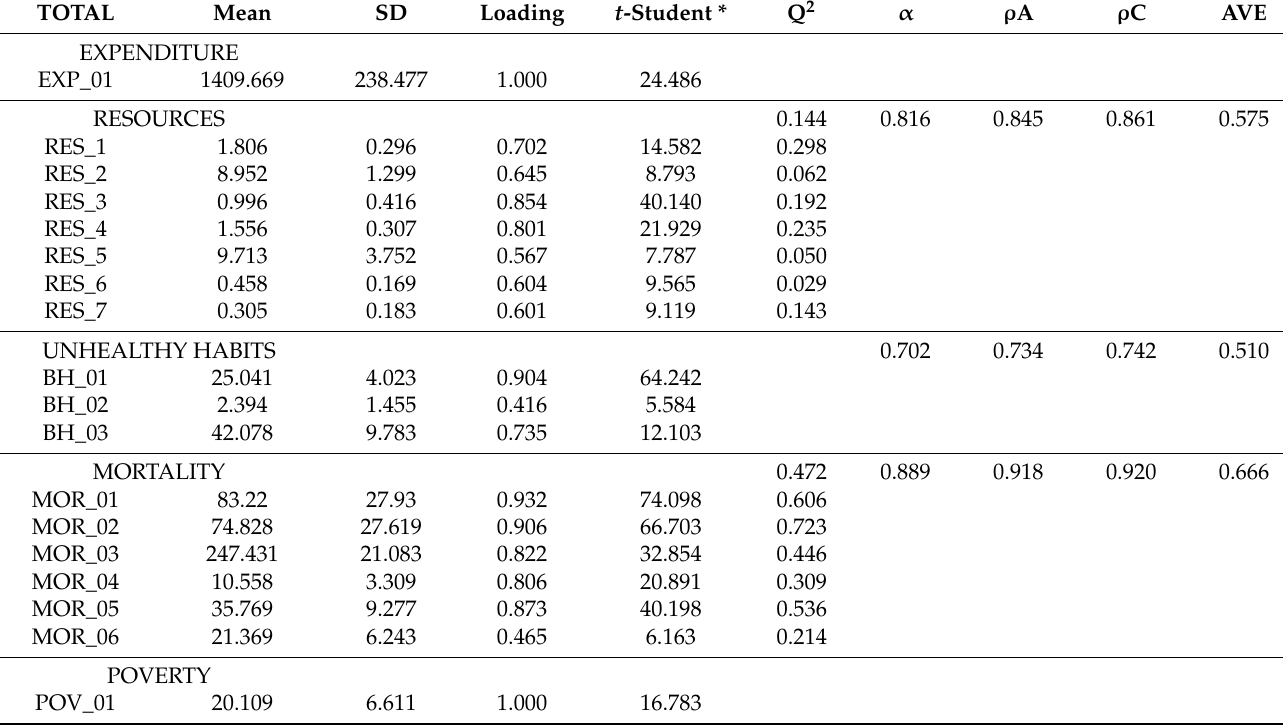
Table 2. Measurement